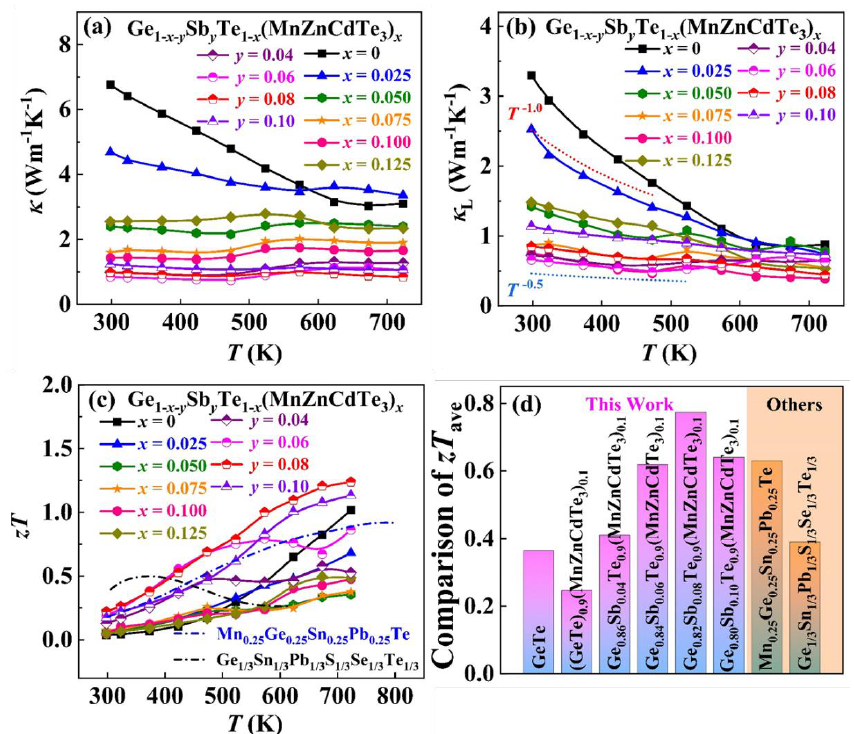
Figure 5. Temperature dependences of ( a ) total thermal conductivity κ , ( b ) lattice thermal conductivity κ L , and ( c ) zT of (GeTe) 1− x (MnZnCdTe 3 ) x and Ge 0.82 − y Sb y Te 0.90 (MnZnCdTe 3 ) 0.10 samples. ( d ) The average zT ave values between 298 – 723 K for our GeTe-based alloys.